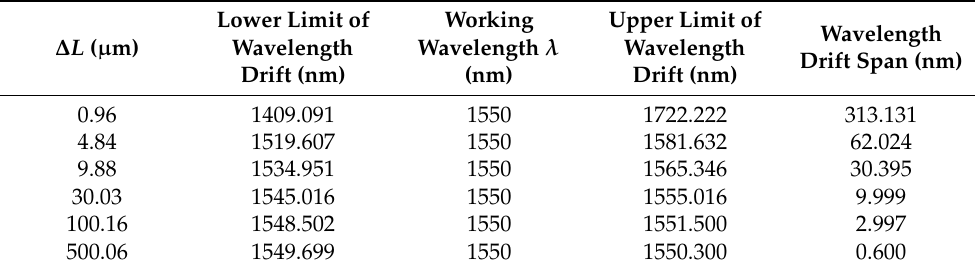
Table 4. Operating wavelength under different ∆ L